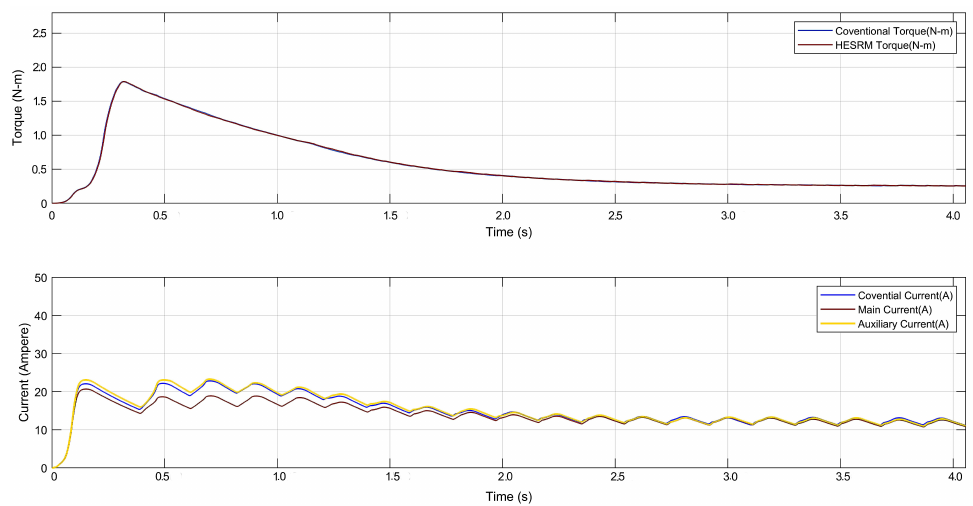
Figure 9. Comparison of closed-loop current control of conventional SRMs and HESRM.